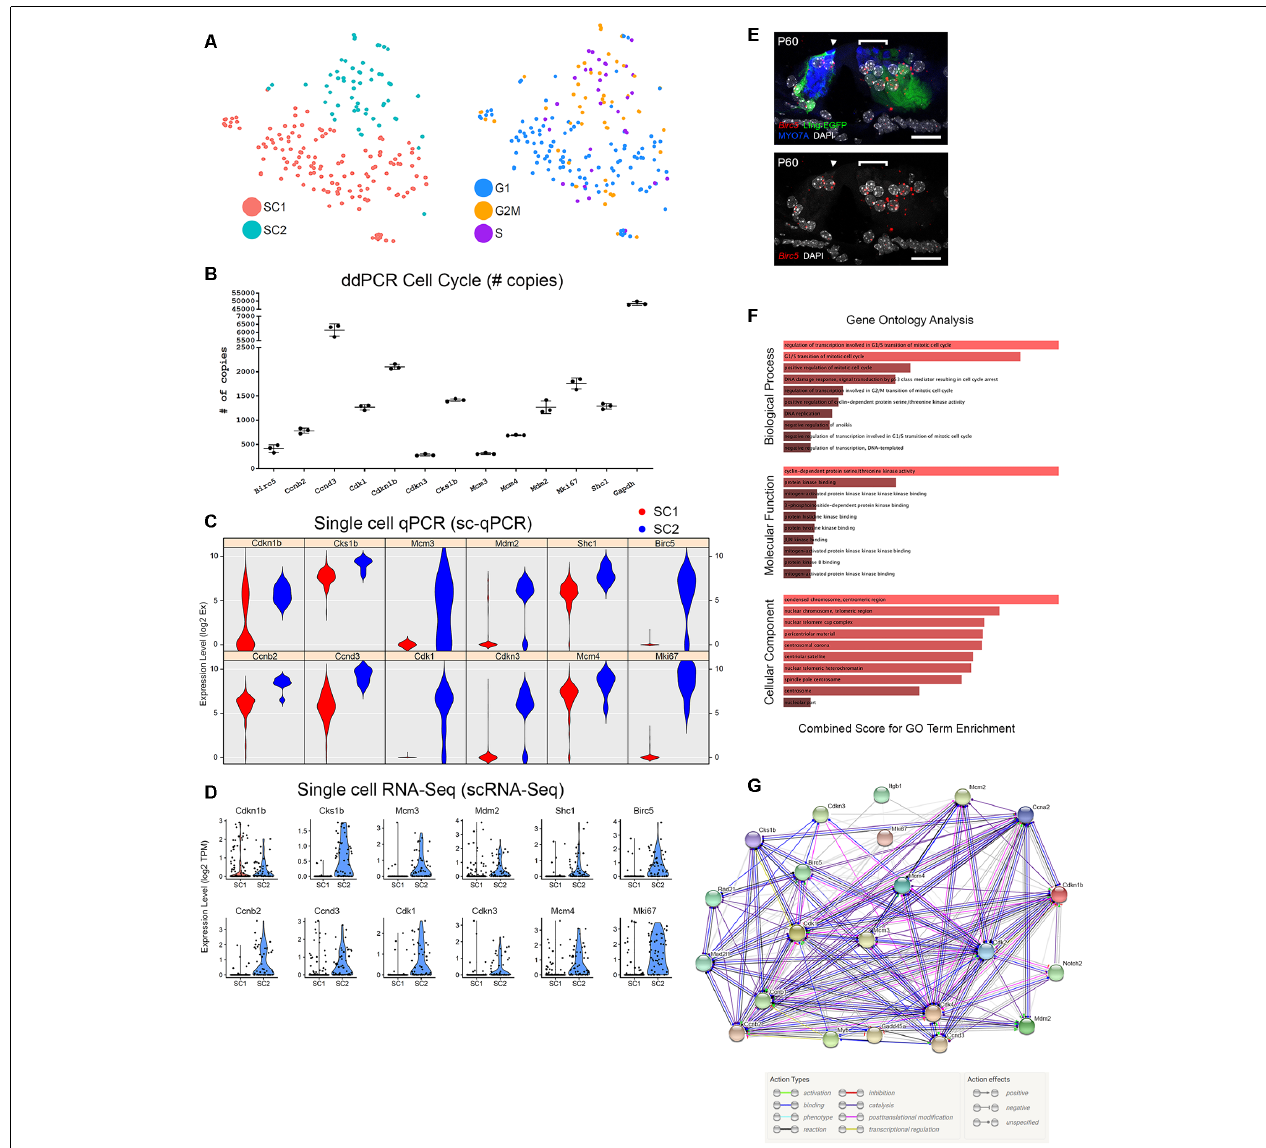
FIGURE 5 | Cell cycle analysis of adult cochlear SCs. (A) Analysis of cell cycle phase among FACS-purified adult cochlear SCs reveals that the SC2 cluster of adult cochlear SCs express predominantly S phase and G2/M phase canonical markers compared to SC1 adult cochlear SC cluster. tSNE plot with the clustered cell types is shown to the left with an accompanying tSNE plot demonstrating cells clustered by cell cycle phase to the right. (B) Single-cell RNA-Seq expression of G2/M and S phase-specific markers. Violin plots for a select group of G2/M and S phase-specific cell cycle-related genes demonstrate predominant expression in the SC2 cluster of adult cochlear SCs. For violin plots, expression level (log2 TPM) is displayed on the vertical axis and cell cluster is displayed on the horizontal axis. (C) Single-cell qPCR of FACS-purified adult cochlear SCs for G2/M and S phase cell cycle-related markers confirms gene expression in adult cochlear SCs. Violin plots are redisplayed from Figure 4D for ease of comparison to the scRNA-Seq results above. (D) Digital droplet PCR (ddPCR) quantifies the presence of the select group of cell cycle-related genes validated by sc-qPCR in FACS-purified P60 Lfng EGFP -positive cochlear SC populations. (E) Cell cycle gene expression is demonstrated in mid-modiolar sections of the P60 mouse organ of Corti. RNA probe (in red) with accompanying immunohistochemistry is shown in image to the left and grayscale single-channel image is shown in image to the right. smFISH probe for Birc5 (red dots) is shown to overlap with adult cochlear SCs (GFP in green). HCs are labeled with MYO7A (blue) and nuclei are labeled with DAPI (white). Location of IHC (arrowhead) and region of outer HCs (bracket) are denoted. Scale bar in all panels, 20 µ m. (F) Gene Ontology (GO) analysis of cell cycle-related genes expressed by FACS-purified GFP-positive cells from P60 Lfng EGFP cochlea suggests that these cells may be maintained in a non-proliferative state by a repressive network of genes. All cell cycle genes expressed by adult SCs from the dataset, regardless of which cluster of adult cochlear SCs expressed these genes, were used as the starting input in Enrichr. GO biological process analysis suggests that genes involved in the G1/S transition of the mitotic cell cycle are prominent in adult cochlear SCs. GO molecular function and cellular component analysis point to cyclin-dependent protein serine/threonine kinase activity and cellular components associated with condensed chromatin at the centromere, respectively. The color of the bar corresponds to the combined score which is calculated by taking the log value of the p -value from the Fisher exact test and multiplying this value by the ( Continued )